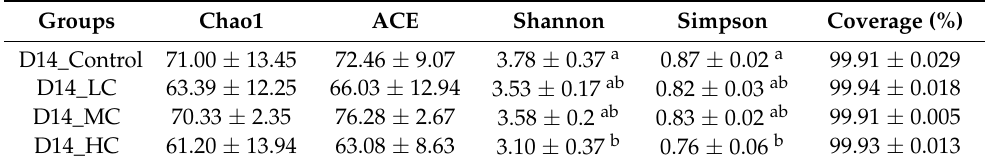
Table 1. Intestinal microbial diversity of that were exposed to FF for 14 days. Groups Chao1